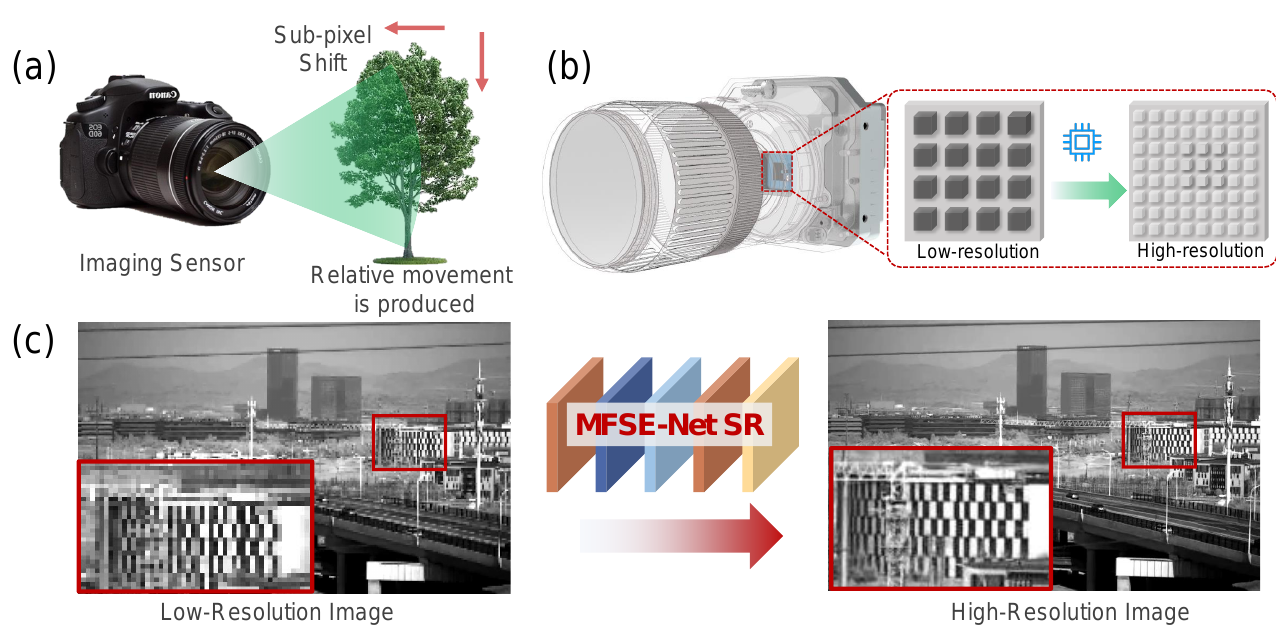
Figure 1. Schematic diagram of super-resolution reconstruction. ( a ) Multi-frame subpixel offset ( b ) Pixel super-resolution diagram ( c ) Super-resolution of a deep neural